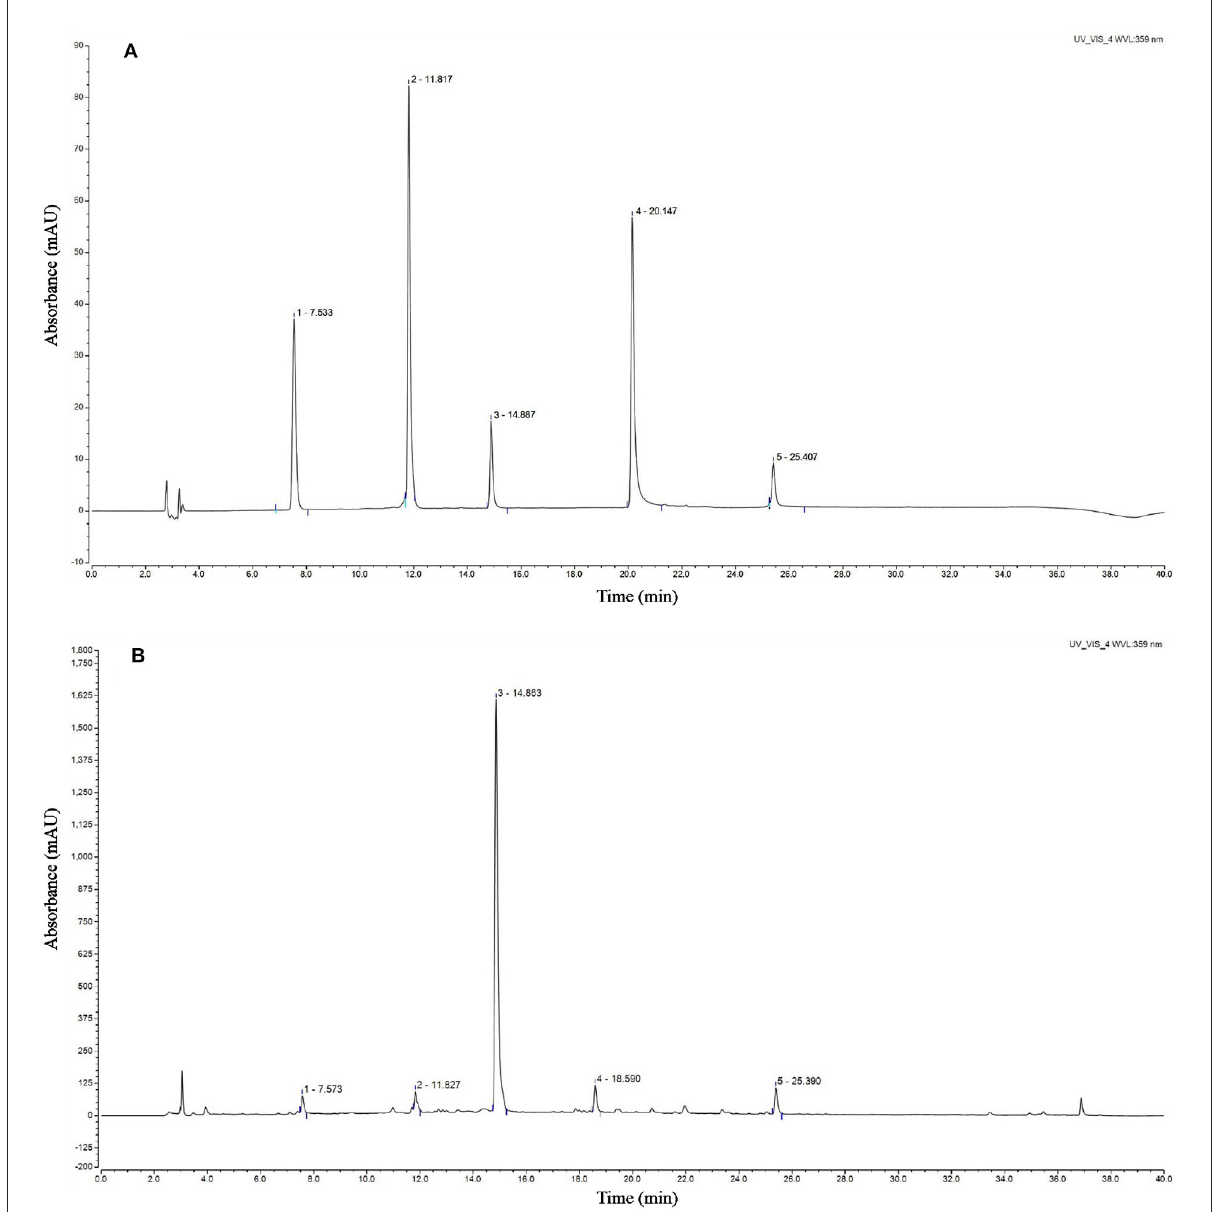
FIGURE8 HPLC chromatogram of Clerodendranthus spicatus (Thunb.) C. Y. Wu extract, (A) standard chromatogram, (B) Clerodendranthus spicatus (Thunb.) C. Y. Wu chromatogram. 1: caffeic acid, 2: isoquercetin, 3: rosmarinic acid, 4; luteolin, 5: baicalin.